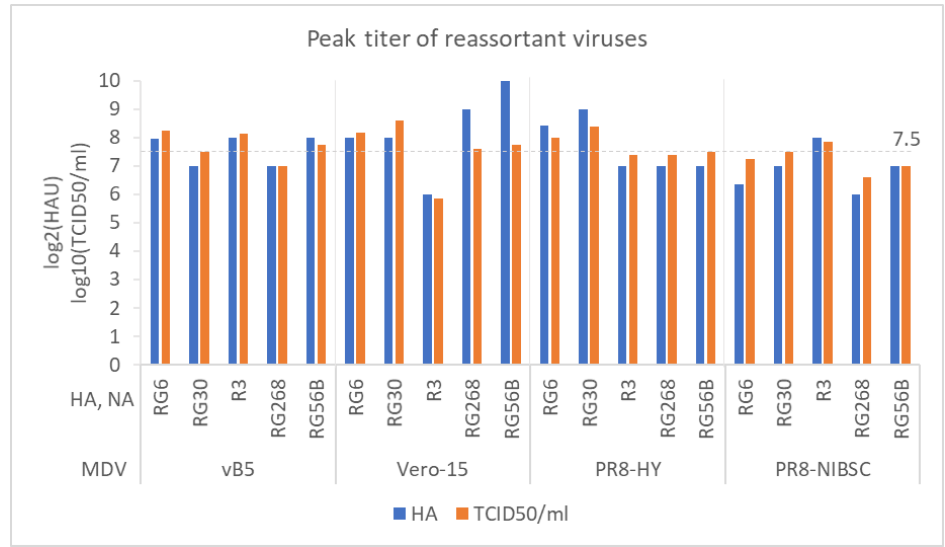
Figure 4. A comparison of virus growth among vB5, Vero-15, PR8-HY, and PR8-NIBSC master donor viruses (MDVs). The HA and NA genes used in this comparison were from RG6, RG30, R3, RG268, and RG56B.